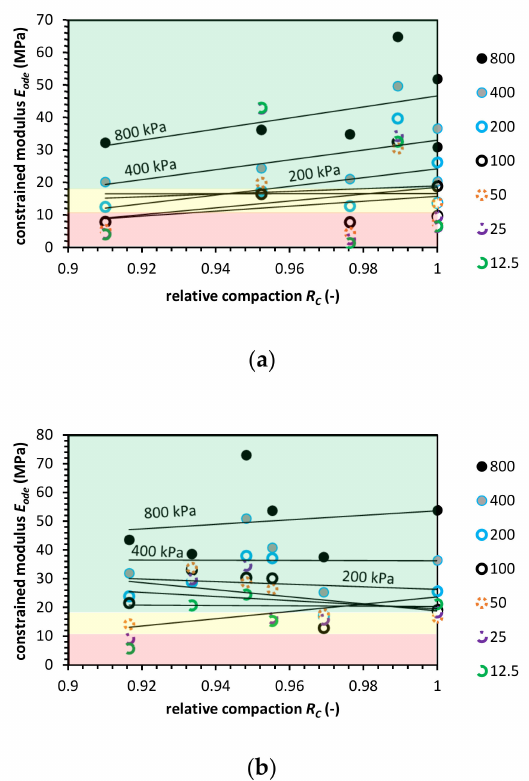
Figure 8. Constrained modulus value versus relative compaction value for blast furnace slag (BFS) for ( a ) the Proctor compaction and ( b ) the Vibro compaction method. Colored areas mean required constrained modulus value, colors indication: green-zone of fulfilled E ode modulus requirement; yellow-moderate zone, where the constrained modulus is in the range of requirements; red-zone in which the E ode do not meet pipe fill